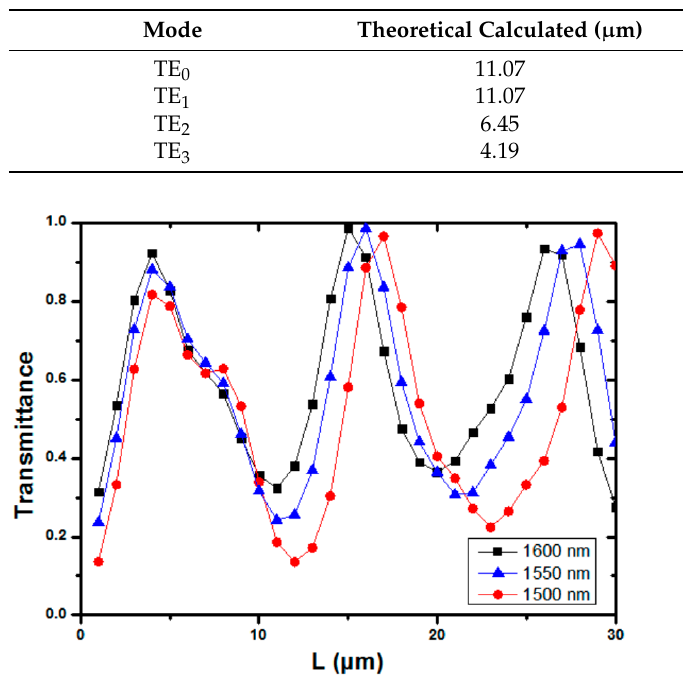
Figure 6. Simulated TE 1 mode at different wavelengths, with multimode bus waveguide width of 1.525 µ m and two Euler bends, with effective radii of 12 µ m each.